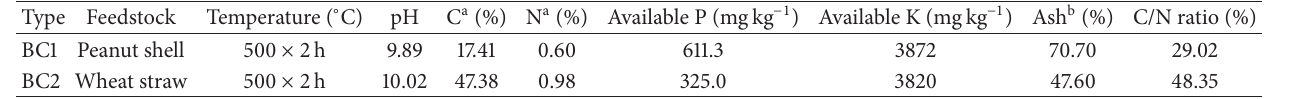
Table 1: Basic properties of biochars used in the